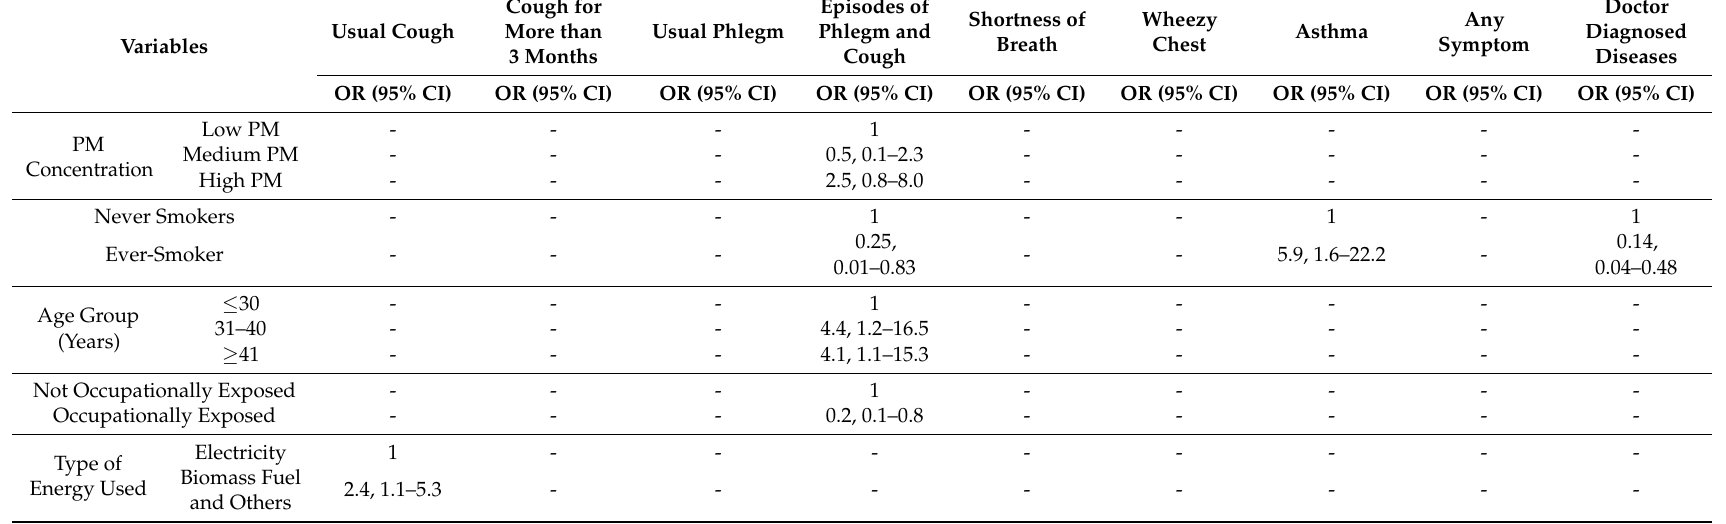
Table 8. Odd ratios (OR) of selected respiratory disorders from unadjusted logistic regression models.